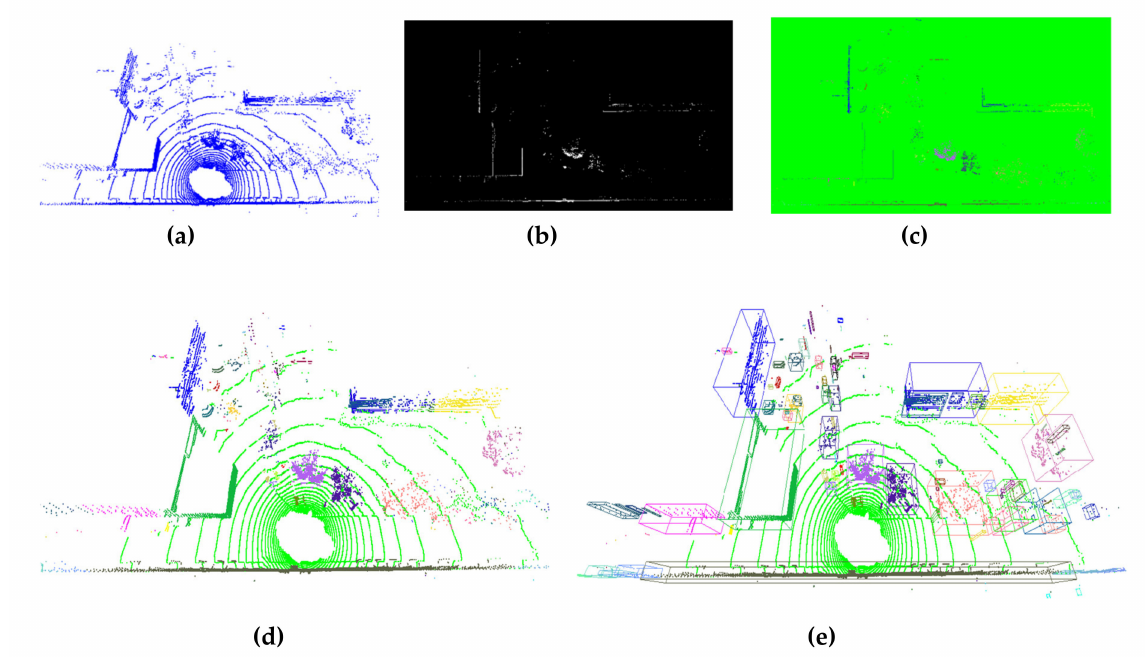
Figure 6. Experimental results obtained by the proposed 3D obstacle labeling method in LiDAR point clouds: ( a ) raw 3D points in the valid range; ( b ) generated obstacle flag map; ( c ) ER-CCL algorithm result on the label map; ( d ) inverse mapping result of 3D obstacle labeling; ( e ) obstacle labeling result with bounding